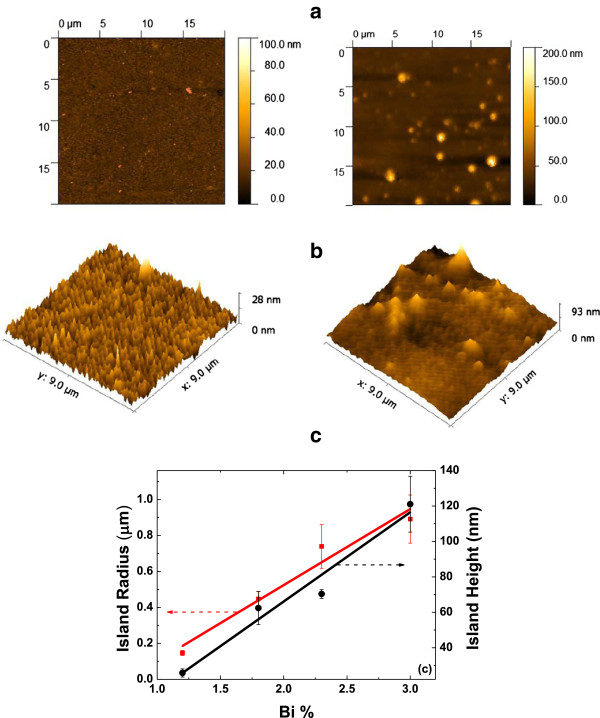
2D and 3D AFM images of the samples and comparison. (a) GaAs0.988Bi0.012 and (b) GaAs0.97Bi0.03. (c) Comparison of radius and height of islands versus Bi concentration.